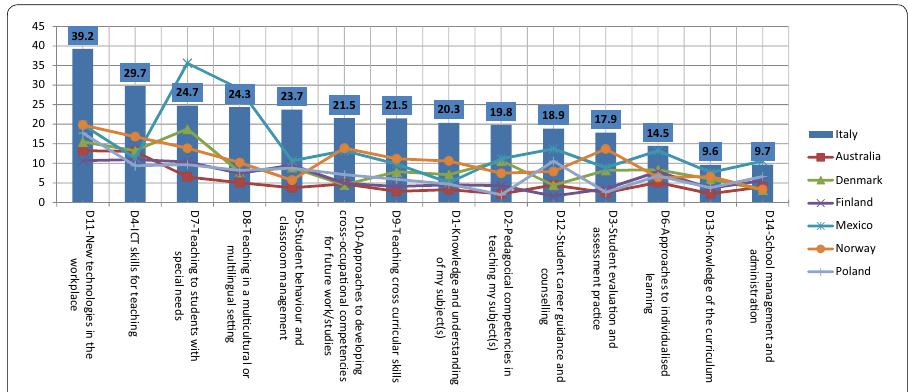
Fig. 2 Upper secondary teachers of vocational subjects declaring a high level need for professional development by domain, 2013 (%). Source: Author’s calculations based on OECD, TALIS